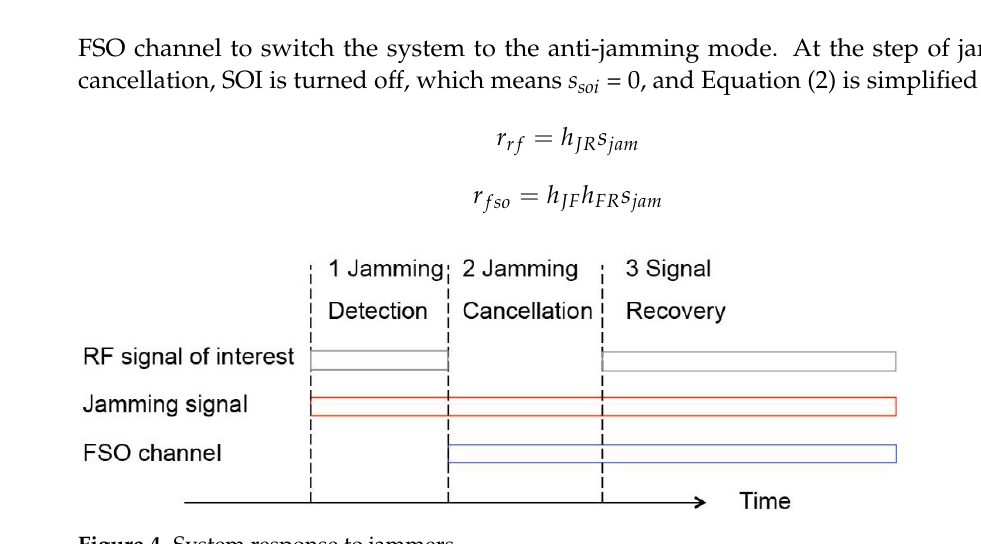
Figure 4. System response to jammers.